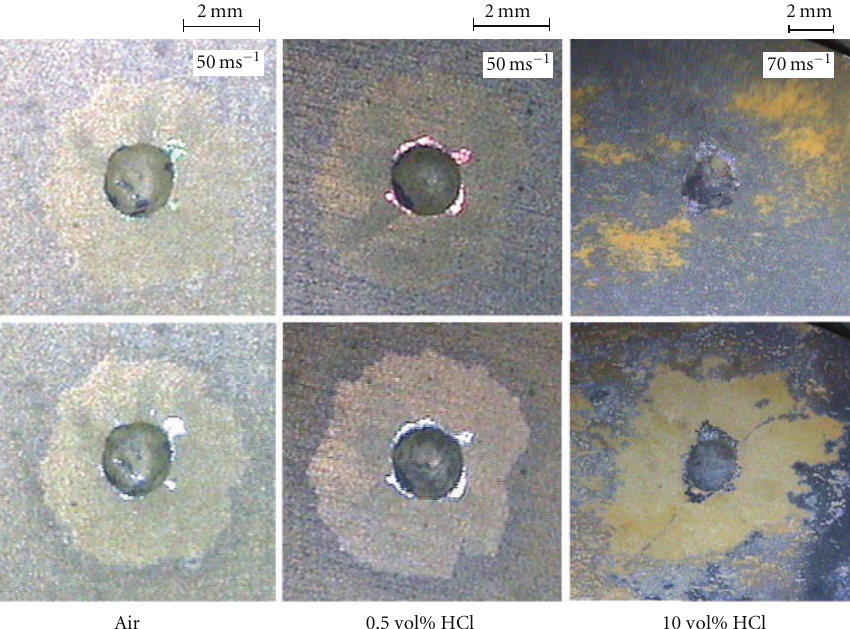
Figure 4: Appearances of oxide films formed on Ti after the impact of a glass bead at 973 K (upper photographs) and at about 10 hours after the impact (lower